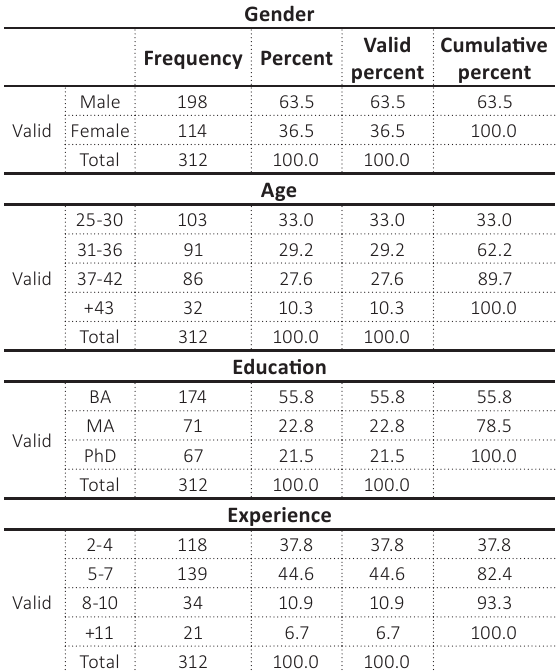
Table 1. Responses distribution according to the